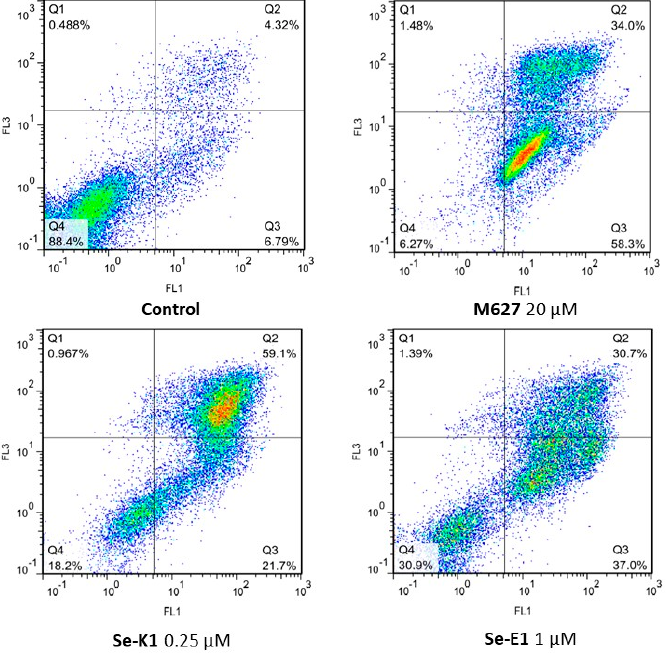
Figure 2. Apoptosis induction in Colo 320 cells by Se-K1 and Se-E1. The 12 H -benzo[ α ]phenothiazine (M627) was applied as a positive control. Table 3. Apoptosis induction in Colo 320 cell line by symmetrical